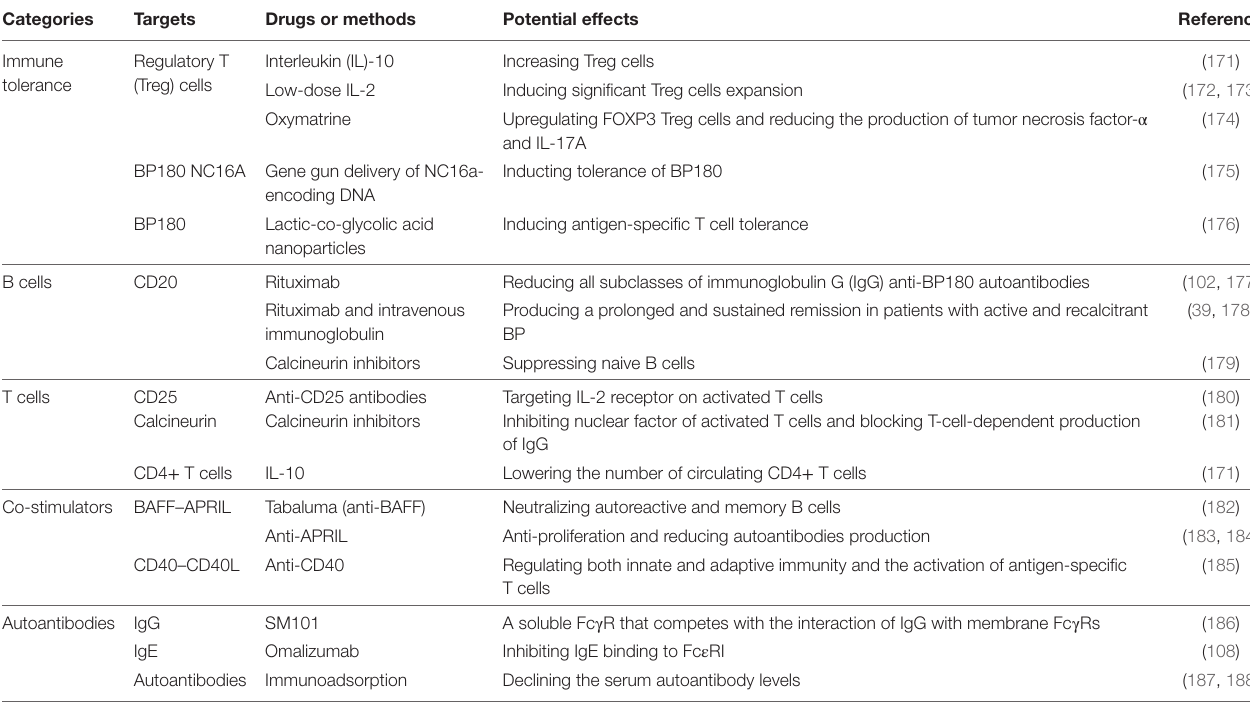
TABLe 1 | Potential treatment targets for bullous pemphigoid